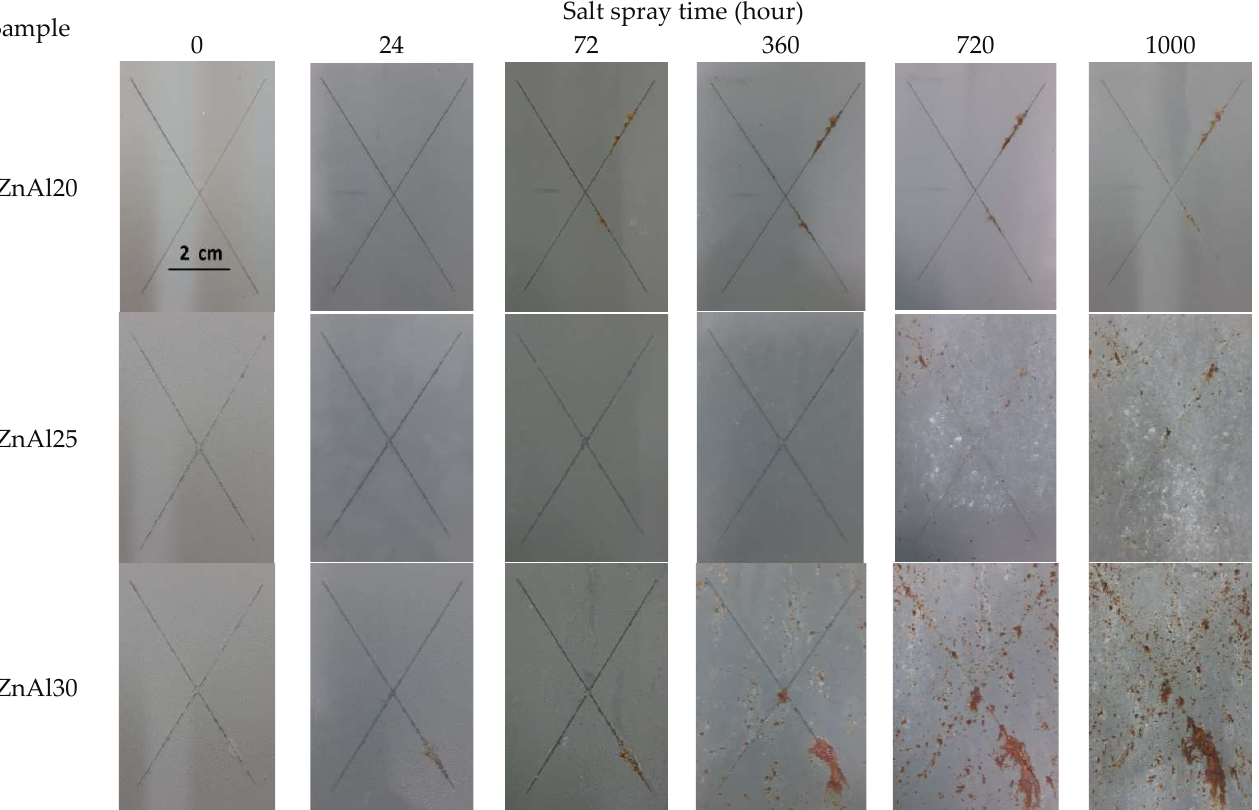
Figure 5. Surface images of silicate coatings after exposure to the salt spray testing for 1000